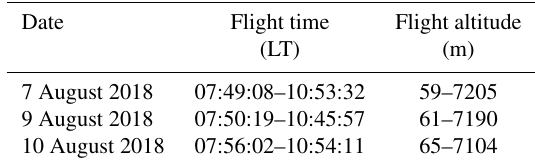
Table 1. Details of the flight on each day.